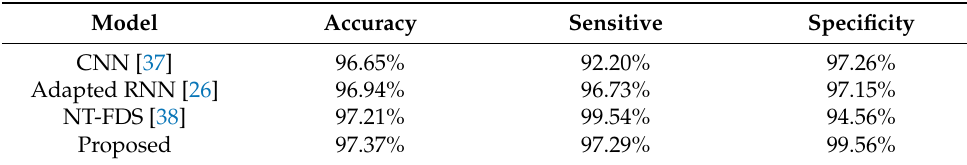
Table 5. Performance comparison with models proposed in other papers.